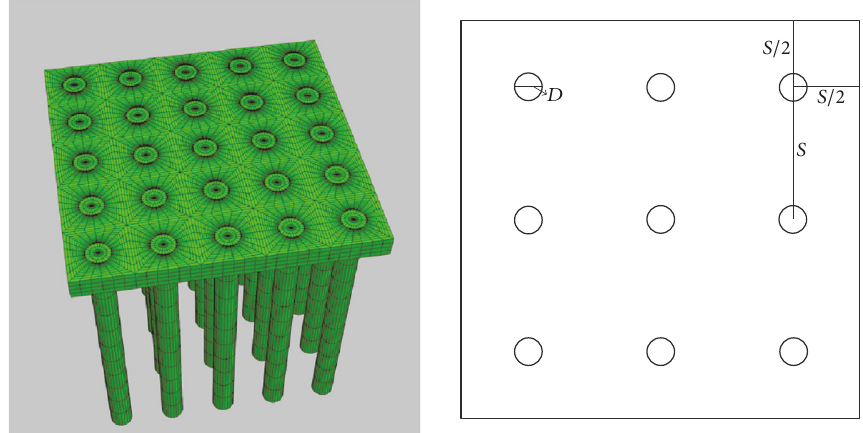
Figure 6: Developed three-dimensional FD